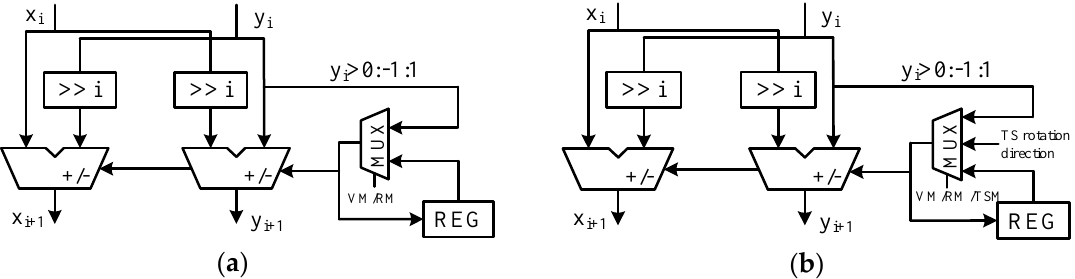
Figure 11. Architecture of micro-rotations of adopted CORDIC module: ( a ) micro-rotation for normal CORDIC module; ( b ) micro-rotation for time-sharing CORDIC module.